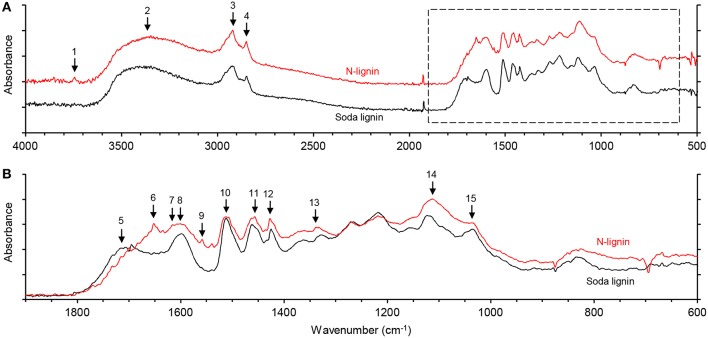
FT-IR spectra of N-lignin and GreenValue wheat straw soda lignin. (A) Full spectra. (B) Overlaid spectra at 1900–600 cm−1. See text and Table 2 for signal assignments.